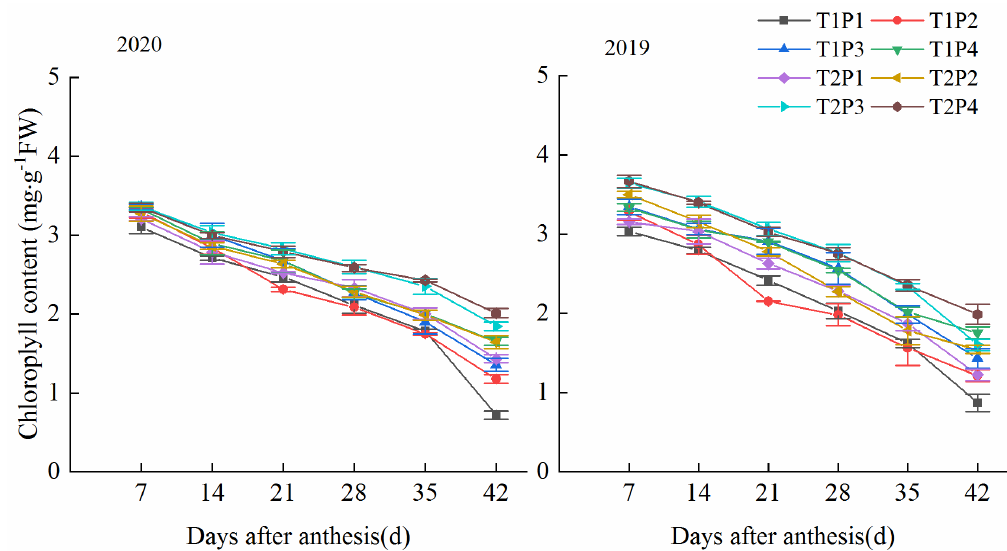
Figure 3. Chlorophyll content of rice post-shoot flag leaves under different treatments in 2019 and 2020. Note: T1, no straw return; and T2, straw returning. P — No P application; P2 — P application on